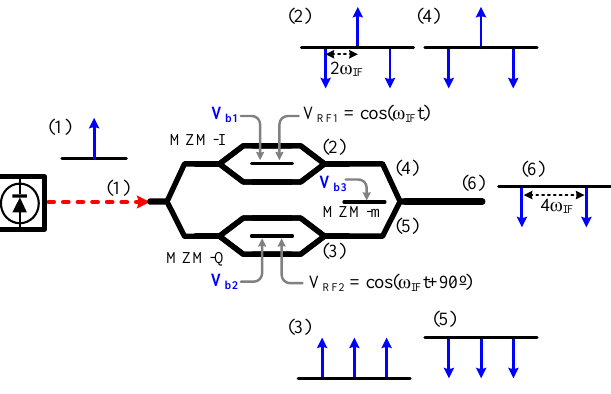
Figure 1. Structure of the DPMZM and principle of the quadrupled signal